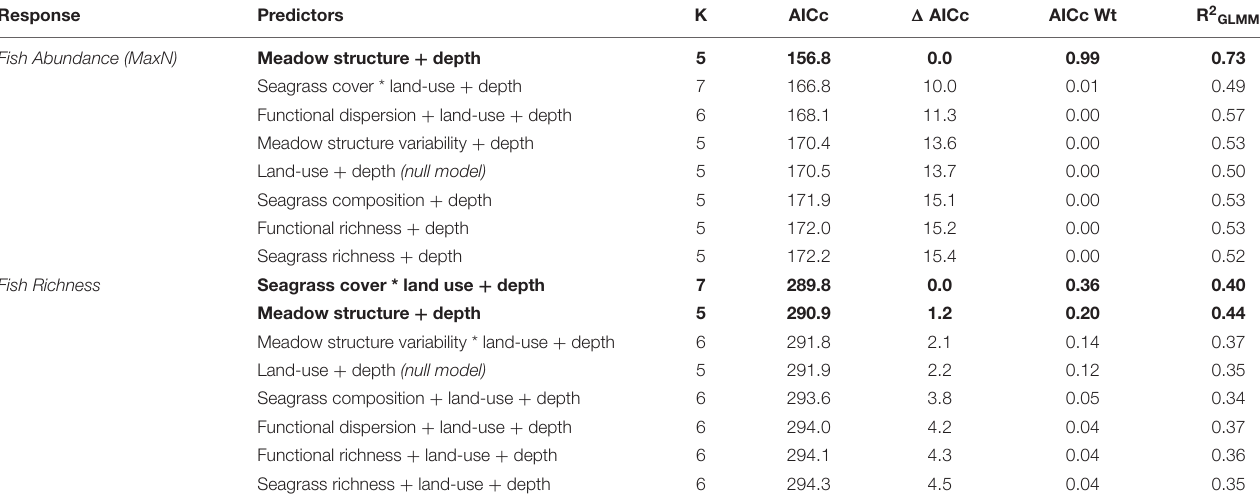
TABLE 4 | Candidate models for fish abundance (MaxN) and richness, sorted by AIC corrected for small sample sizes. Response